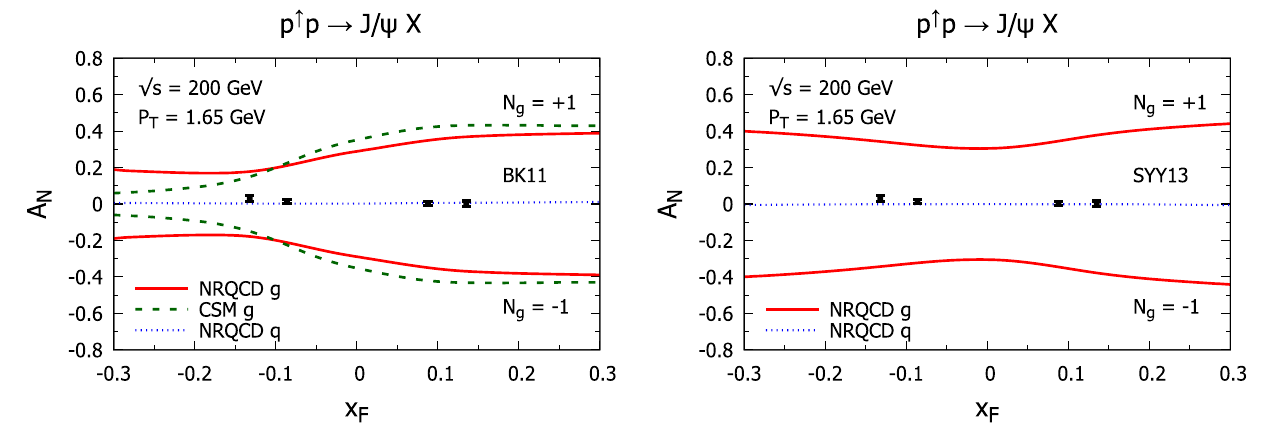
the BK11 (left panel) and the SYY13 (right panel) LDME sets. Notice that for the SYY13 set only CO states are included (see text for further details). Data are taken from [8]